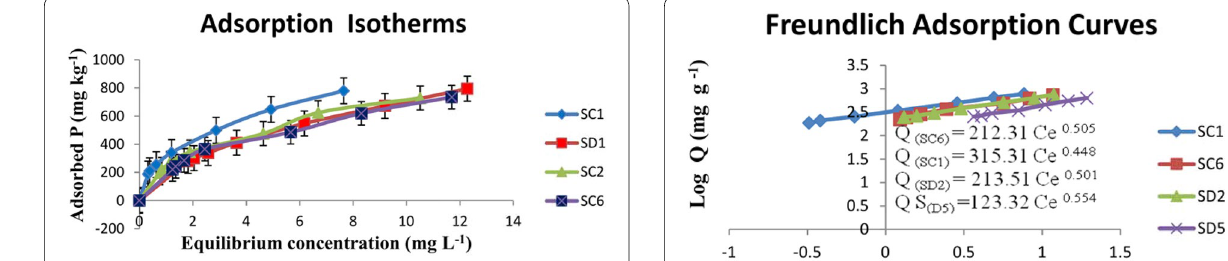
Fig. 2 Adsorption Isotherms of SC1, SD1, SC2 and SC6 soils